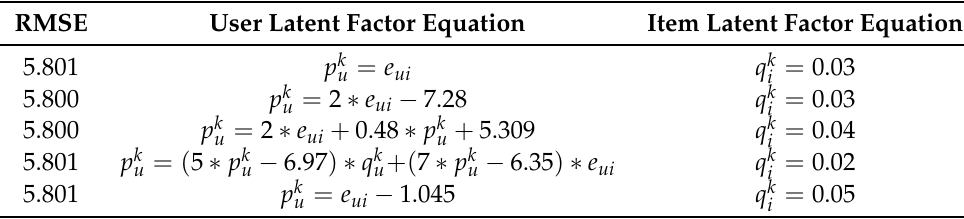
Table 11. Jester optimization results.